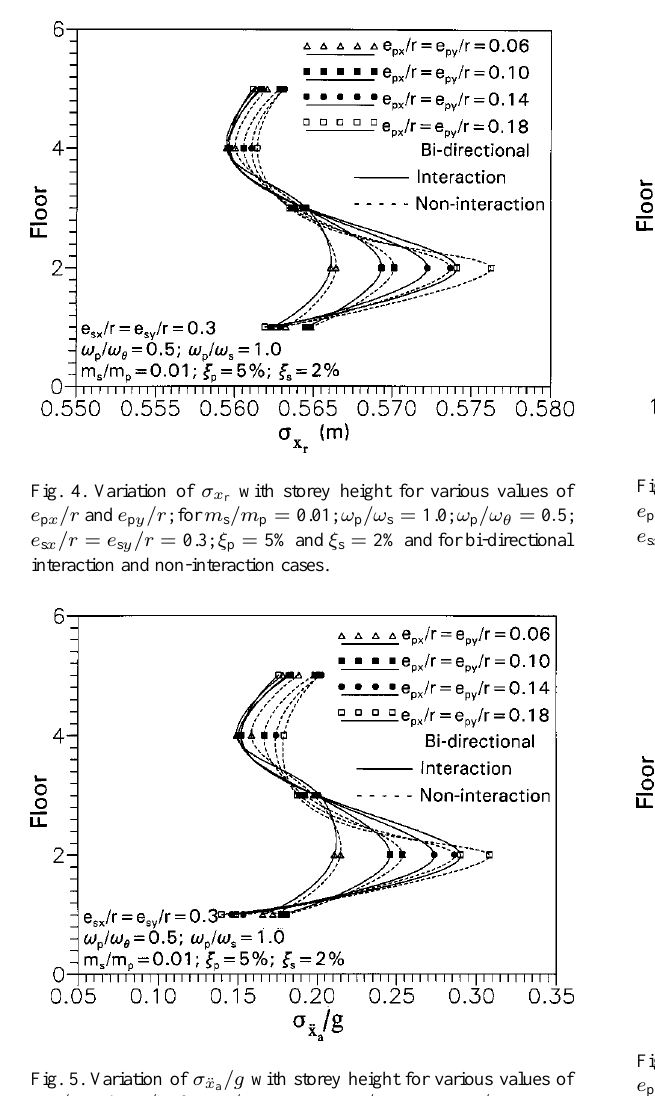
=g with storey height for various values of Fig. 5. Variation of (cid:27) (cid:127) x a e p x =r and e p y =r ; for m s =m p = 0.01; ! p =! s = 1.0; ! p =! (cid:18) = 0.5; e s x =r = e s y =r = 0.3; (cid:24) p = 5% and (cid:24) s = 2% and for bi-directional interaction and non-interaction cases.